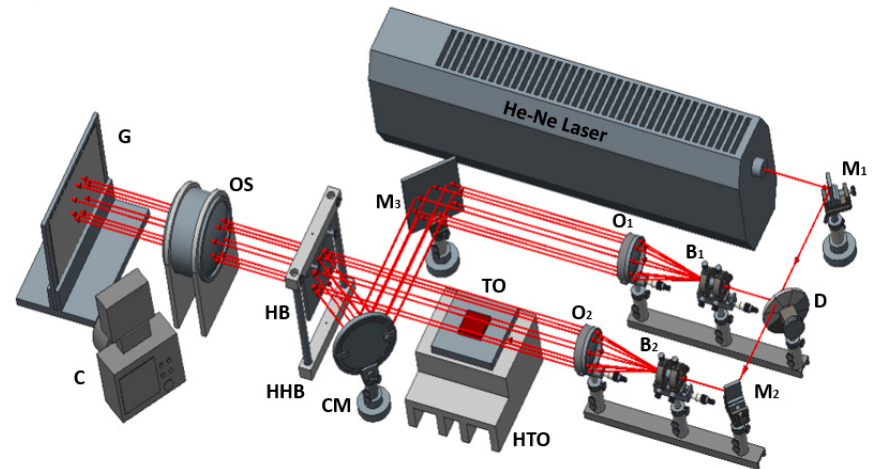
Figure 3. Configuration of a holographic variant of a single-wave Mach–Zehnder interferometer